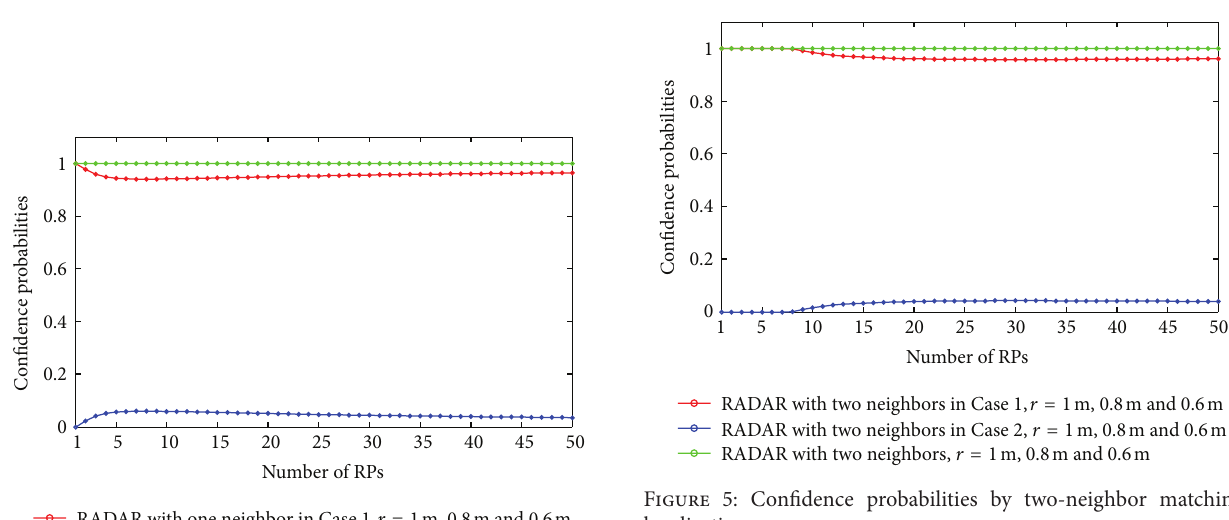
Figure 2: Expected errors by one-neighbor matching localization.